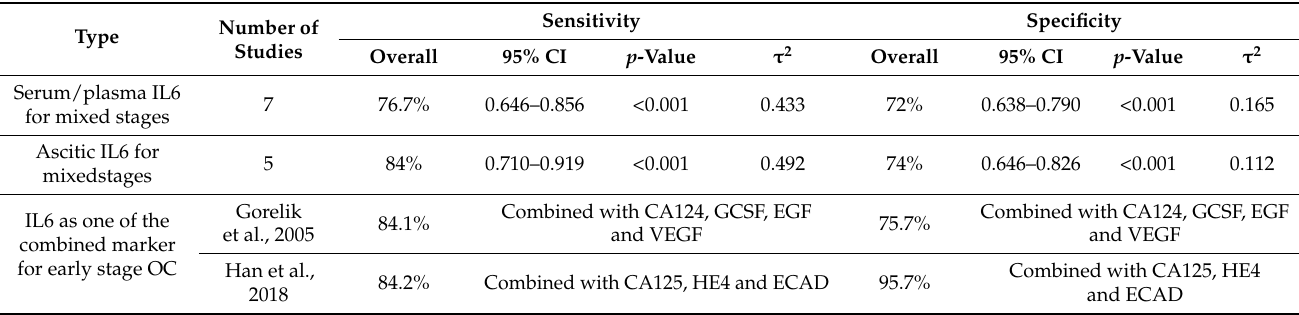
Table 3. The overall sensitivity and specificity performance of serum/plasma or ascitic IL6 to correctly indicate the presence of OC from healthy and benign